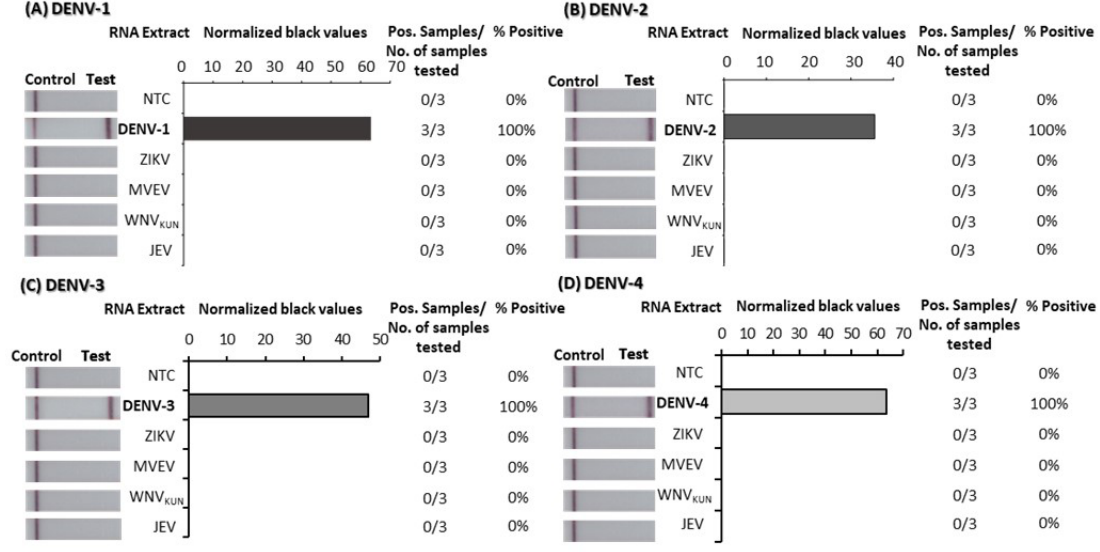
Figure 4. Analytical specificity testing of dengue virus (DENV) 1–4 reverse-transcription recombinase polymerase amplification lateral flow detection (RT-RPA/LFD) tests against other flavivirus RNA extracts. Specificity was tested using viral RNA extracts from the flaviviruses Zika virus (ZIKV), Murray Valley encephalitis virus (MVEV), West Nile virus Kunjin strain (WNV virus (JEV) for DENV-1 ( A ), DENV-2 ( B ), DENV-3 ( C ) and DENV-4 ( D ) RT-RPA/LFD assays. Images of lateral flow strips (LFS) with two bands (control and test band) indicates the sample is positive for respective DENV synthetic RNA transcript, and single control band indicates a valid reaction with negative sample. Nuclease-free water was tested as the no template control (NTC; left). Normalised pixel density (black values) from the assay displayed (middle). Positive (Pos.) samples compared to number (No.) of samples tested using different viral RNA extracts were used to calculate percentage of positive samples